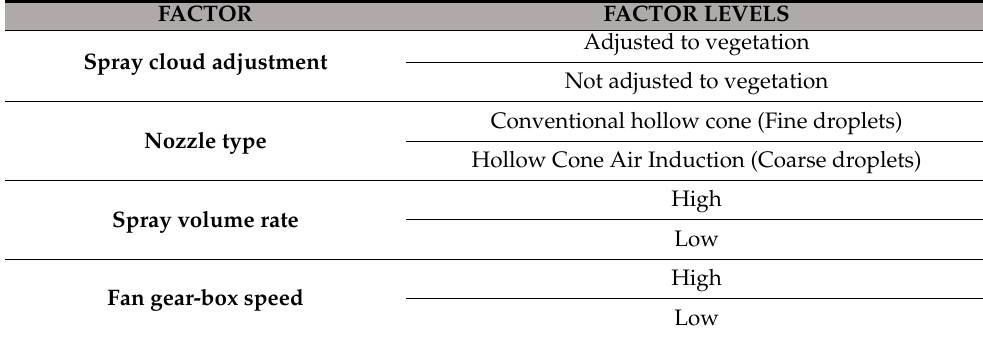
Table 1. Study factors for the evaluation of the vertical spray